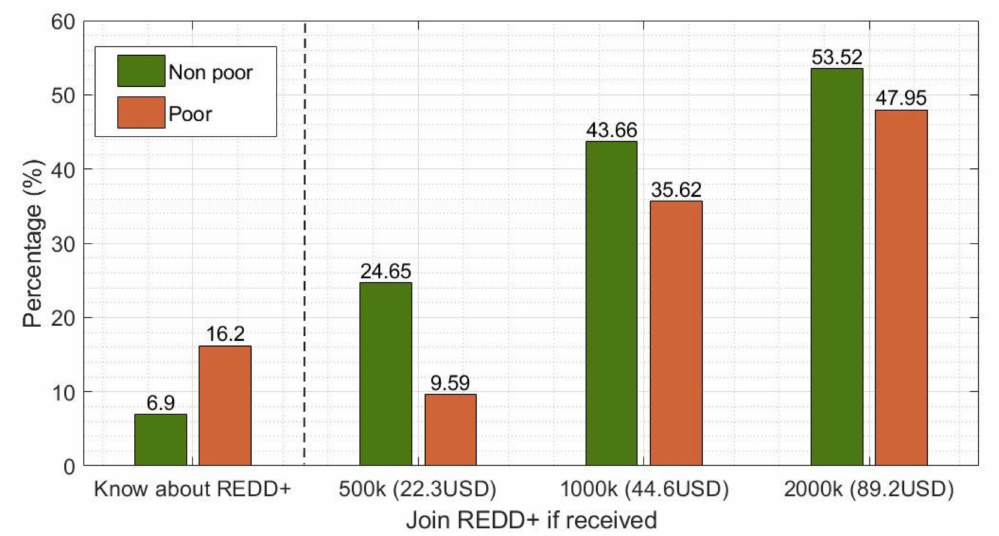
Figure 5. Participation in the REDD+ project of poor households and non-poor households with subsidies. Source: [36] (Note: “k” stands for “thousand”; subsidies are measured in VND per hectare per